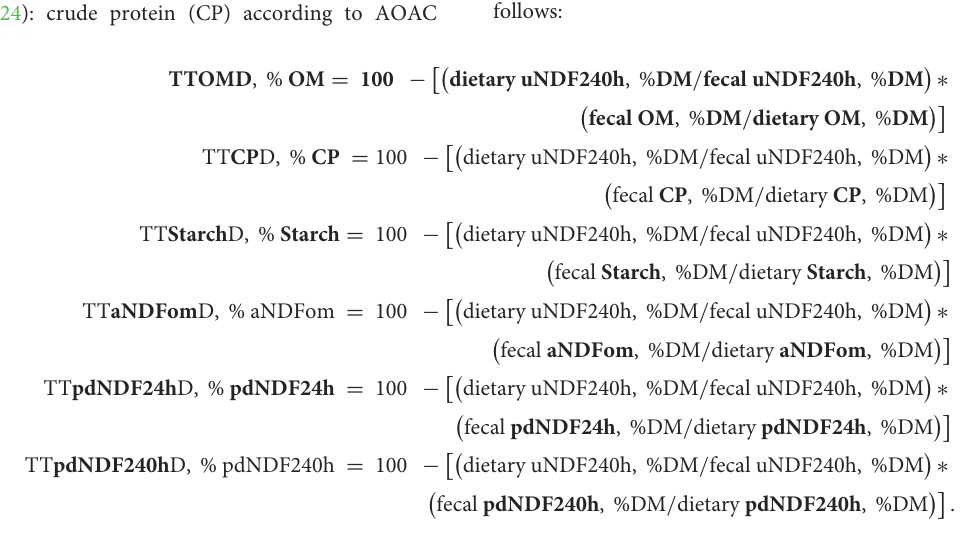
rumination monitoring system (SCR Engineers Ltd.,